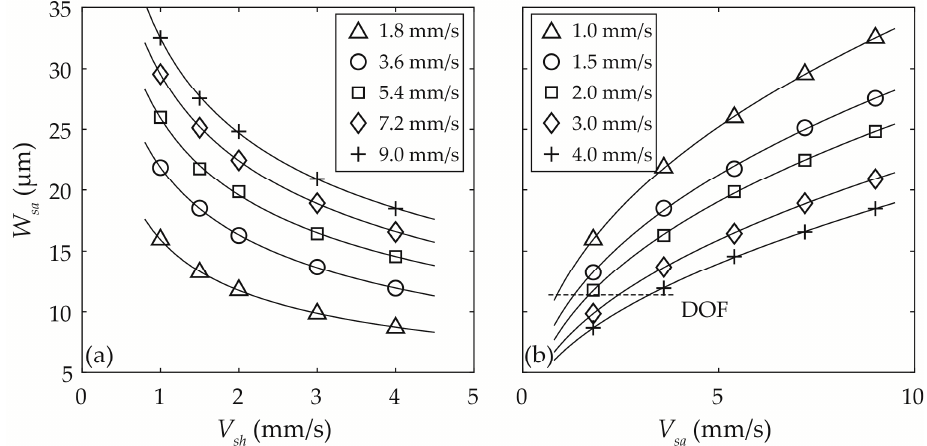
Figure 6. The width of sample particle stream W sa as a function of ( a ) sheath flow velocity V sh at five di ff erent sample flow velocities V sa , and ( b ) V sa at five di ff erent V sh . The dashed line in ( b ) is half of the depth of field (DOF) of the imaging device (i.e., 11.38 µ m). Table 6. The fitted coefficients of the width of sample particle stream W sa versus sheath flow velocity V sh at five different sample flow velocities V sa .